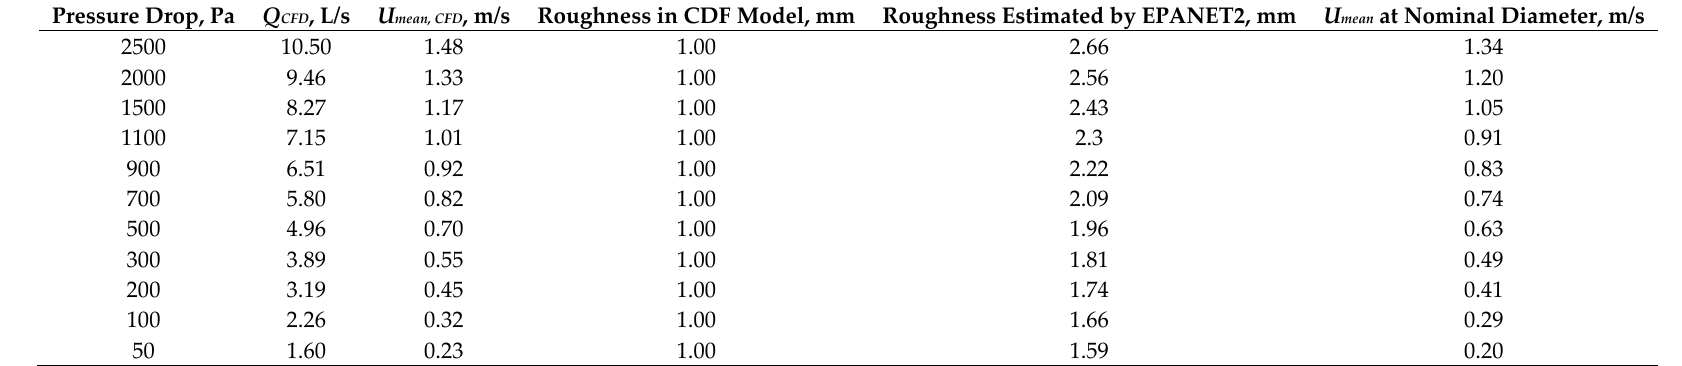
Table 1. Modelled average velocities and estimated roughness using CFD and